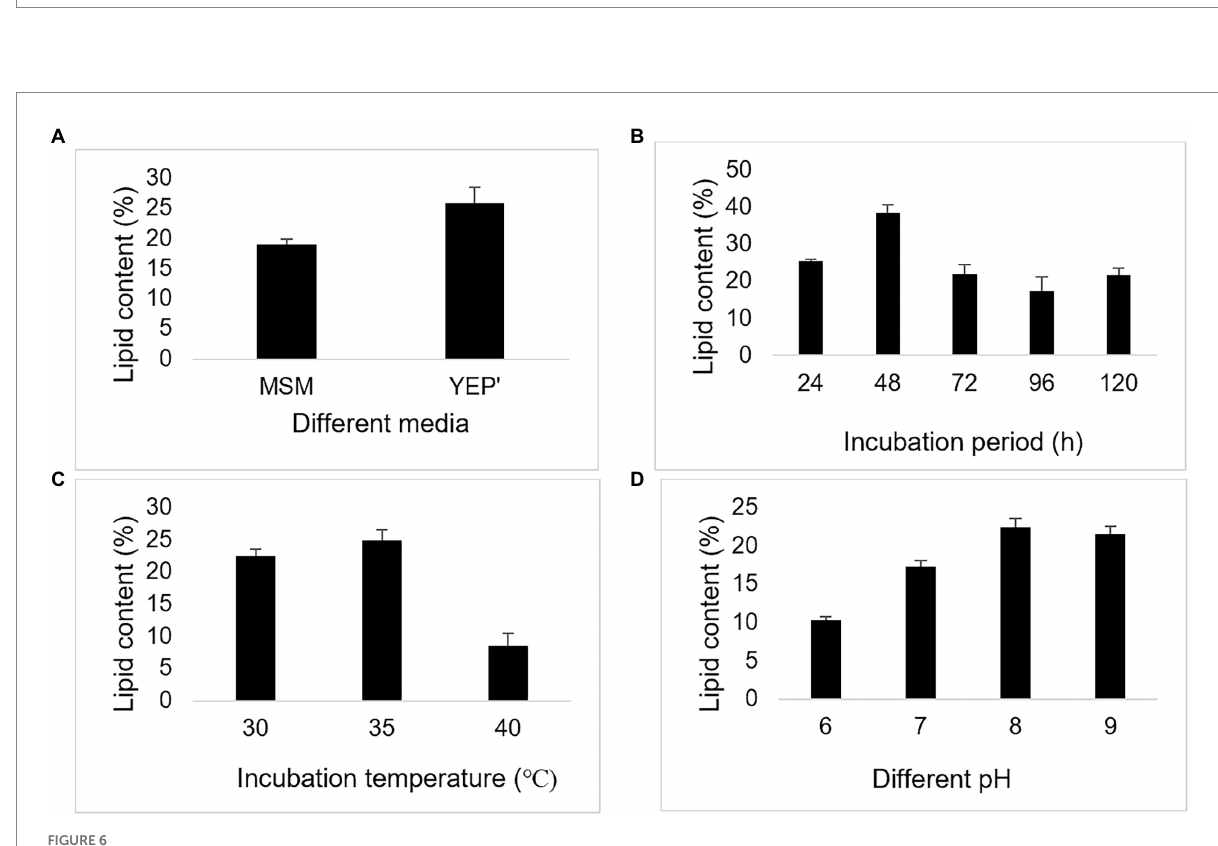
FIGURE 6 Lipid content exhibited by Bacillus sp. at different conditions (A) different media, (B) different incubation period (h), (C) temperature ( ° C), and (D)